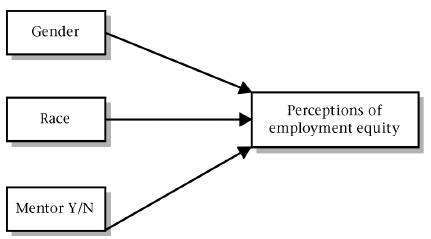
Figure 12: Biographical variables as predictors of the perceptions of employment equity